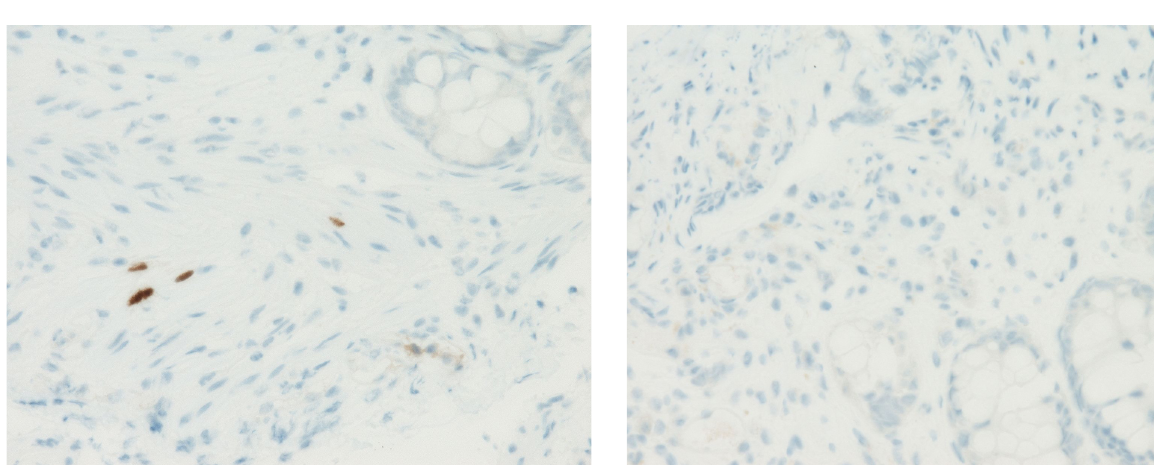
Fig. 1. Positive CMV immunohistochemistry staining. Dark dots are CMV positive endothelial cell.